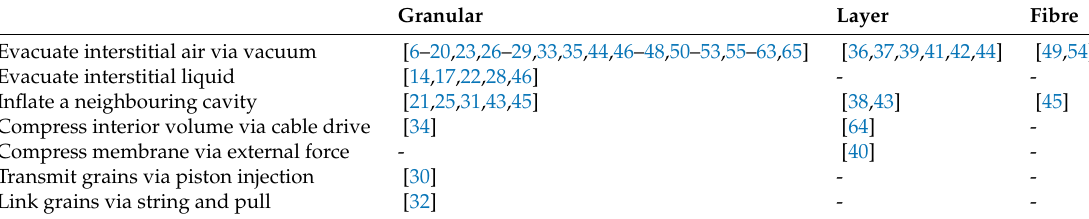
Table 1. Frequency of jamming actuation mechanism per jamming